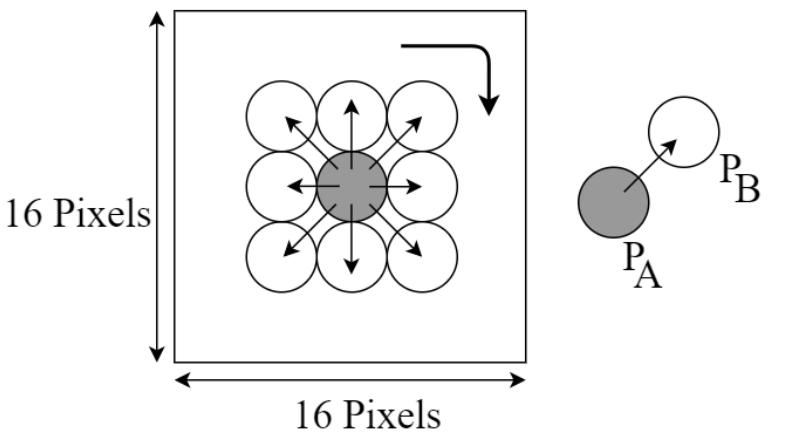
Figure 7. Neighbors operation in